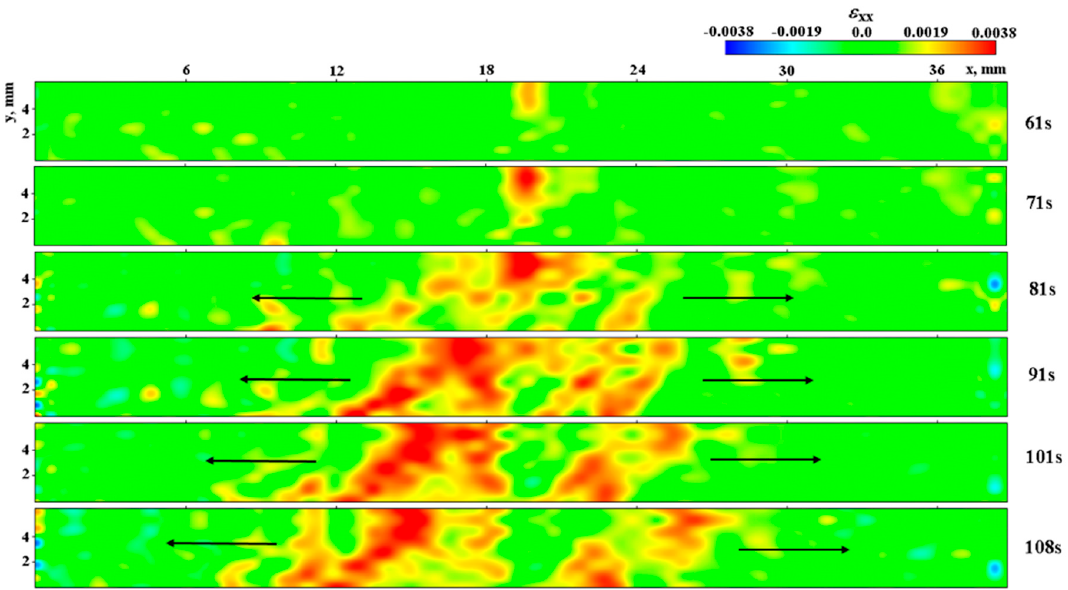
Figure 4. Nucleation and propagation of localized deformation fronts in state 2 . The arrows indicate the front propagation direction.